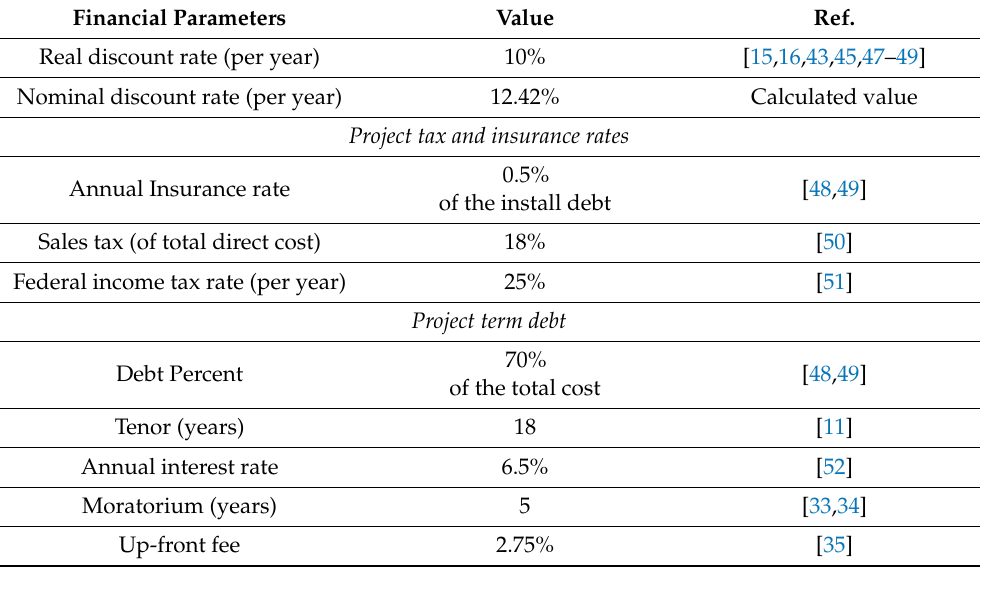
Table 1. Financial parameters used in the SAM simulation.